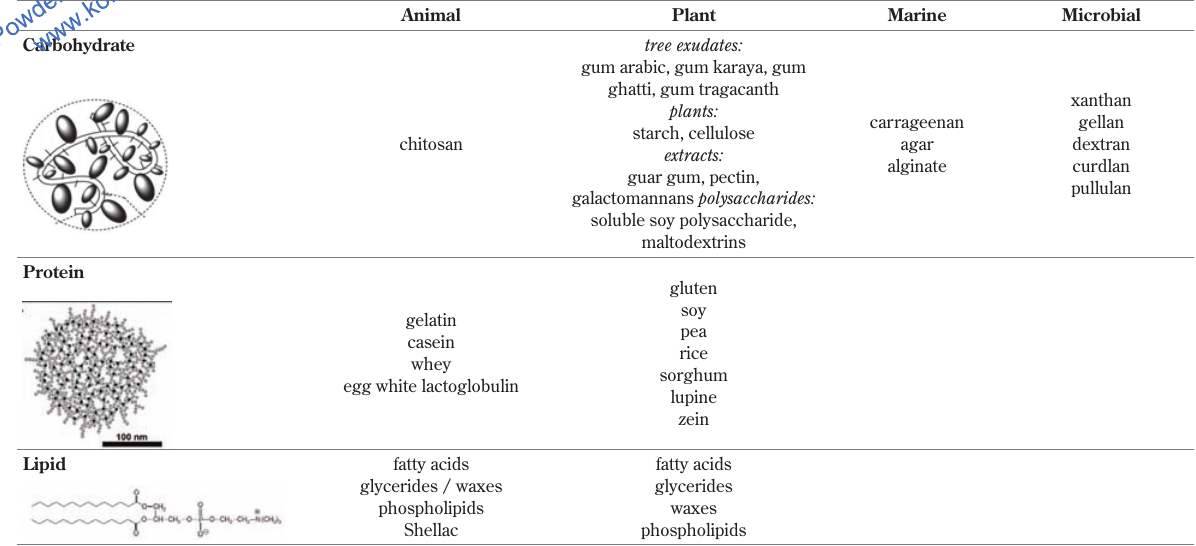
Table 2 Commercially most relevant materials for microencapsulation in the food industry 16, 23)